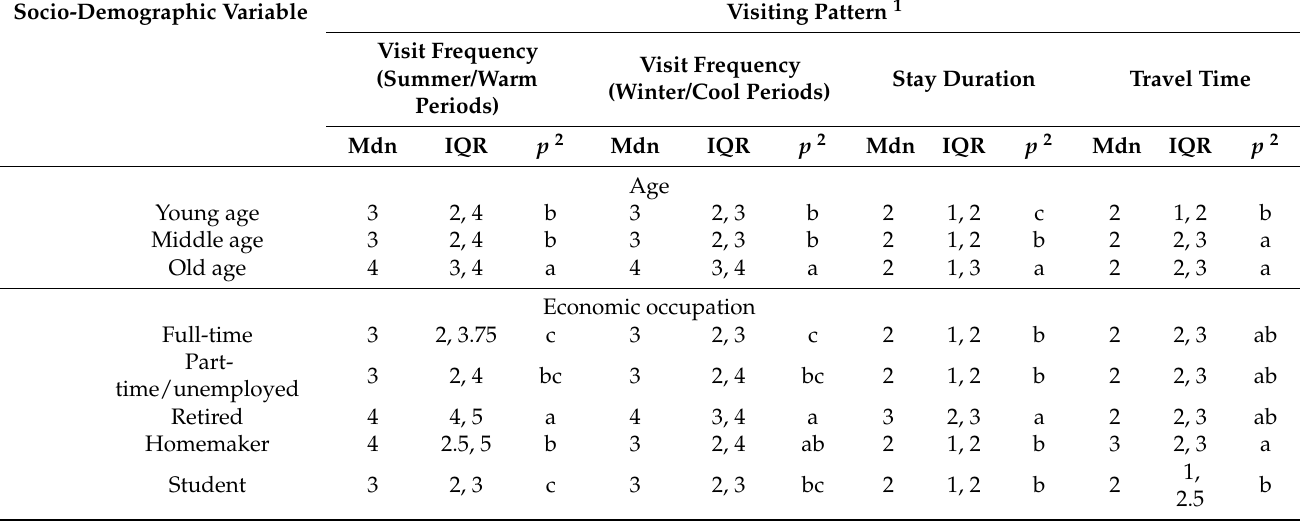
Table 2. The visiting patterns of the respondents (%) in relation to six socio-demographic factors by three age sectors (A), indicated by the median (Mdn) and interquartile range (IQR) of the ordinal scale of visiting frequency, stay duration, and travel time.